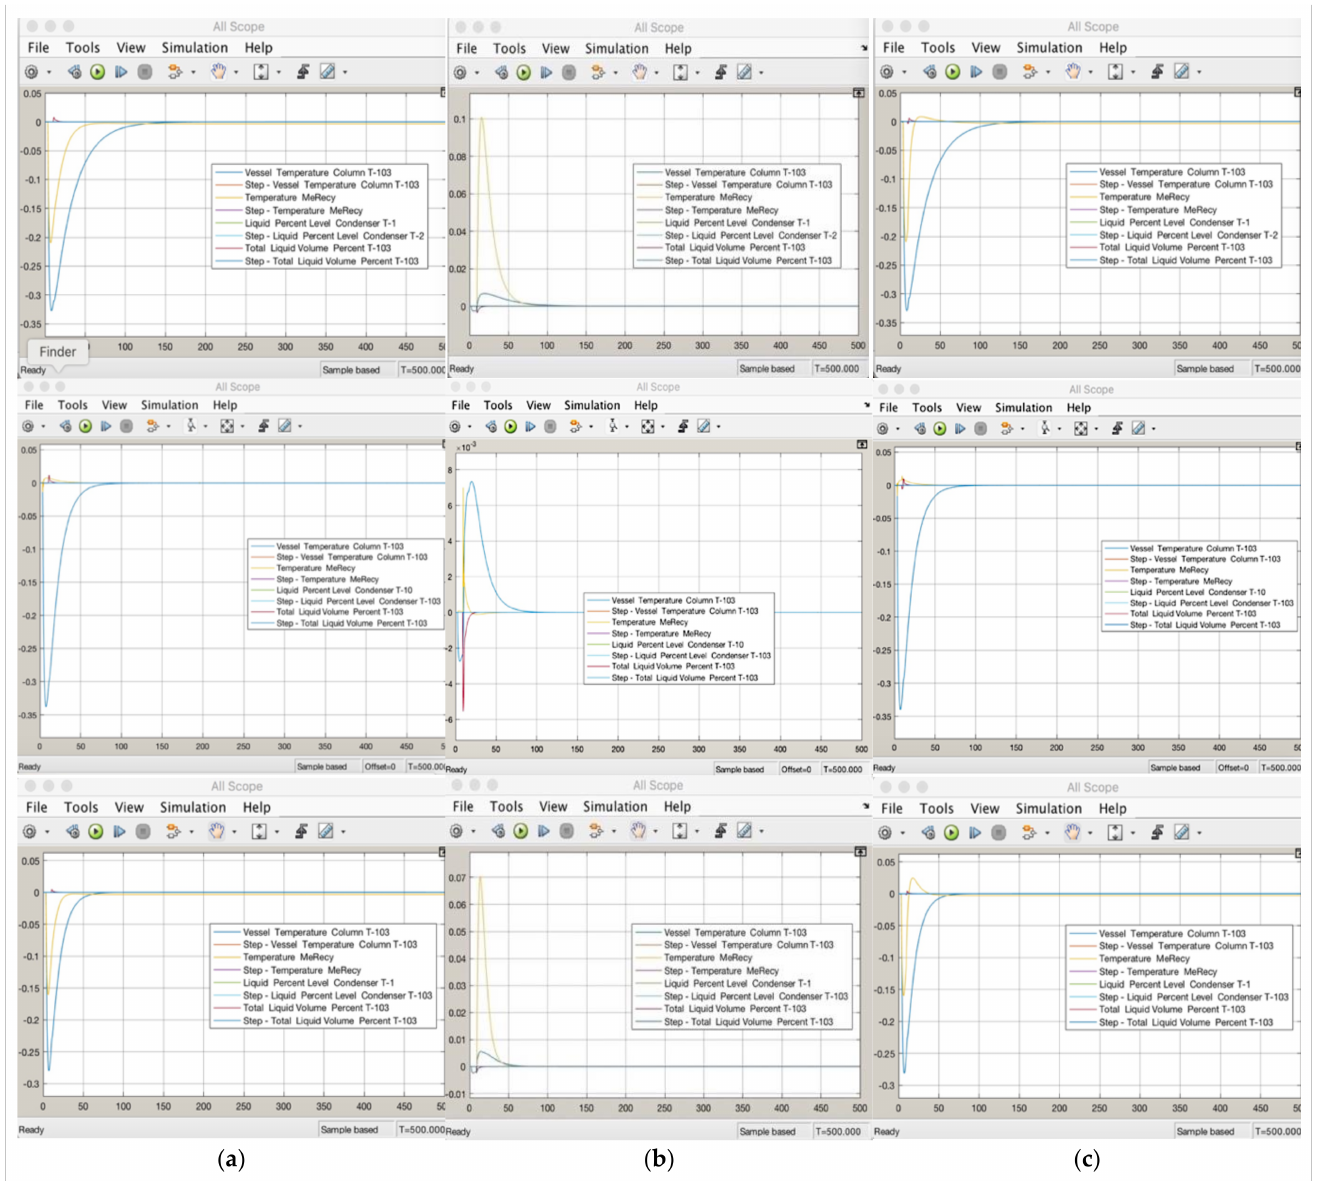
Figure 5. Responses of the methanol purification process using BLT, FT, or WG (top to bottom) with disturbance(s) of ( a ) feed temperature, ( b ) feed flow, and ( c ) feed temperature and feed flow (from left to right). Vessel temperature of Column T-103 (CV1) is colored blue, temperature of the MeRecy stream (CV2) is colored yellow, the liquid percent level of Condenser T-103 (CV3) is colored green, and the total volume percent of T-103 (CV4) is colored red. Step of CV1 is colored orange, Step of CV2 is colored purple, Step of CV3 is colored light blue, and Step of CV4 is colored blue. Note that the CVs are analyzed, so none are manually increasing, and thus there are no changes in the step